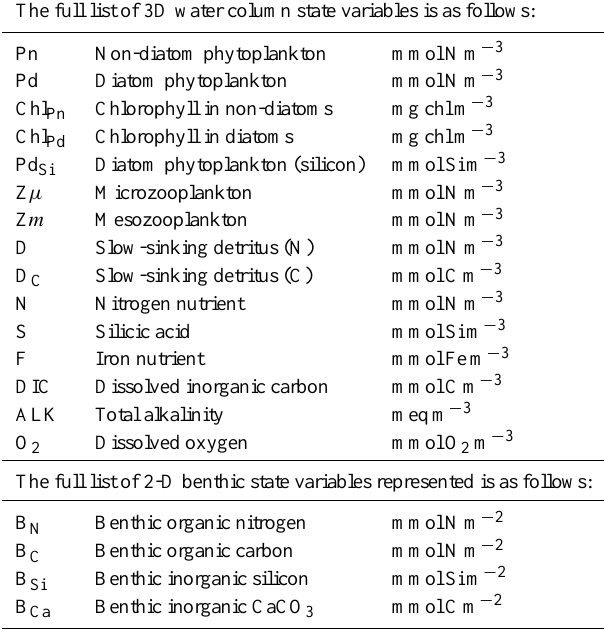
Table A1. MEDUSA-2.0 state